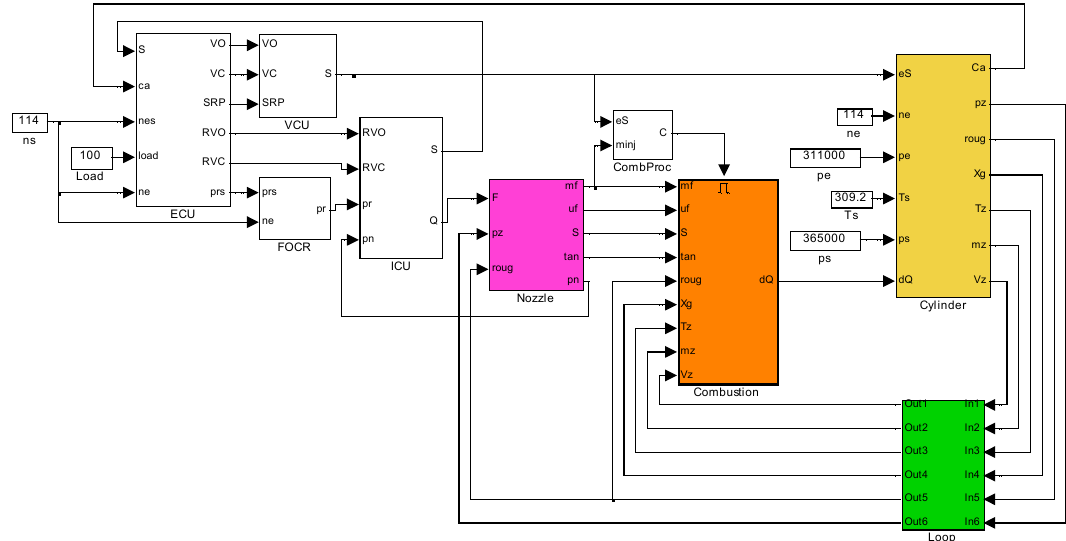
Figure 14. Simulink model for the combustion model.